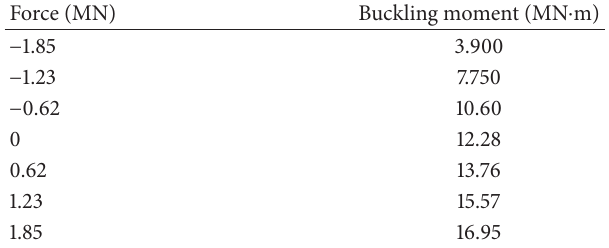
Table 3: Fundamental frequencies for clamped-clamped boundary condition (C-C), when force and end moment are applied; a 40- element FEM model is used.